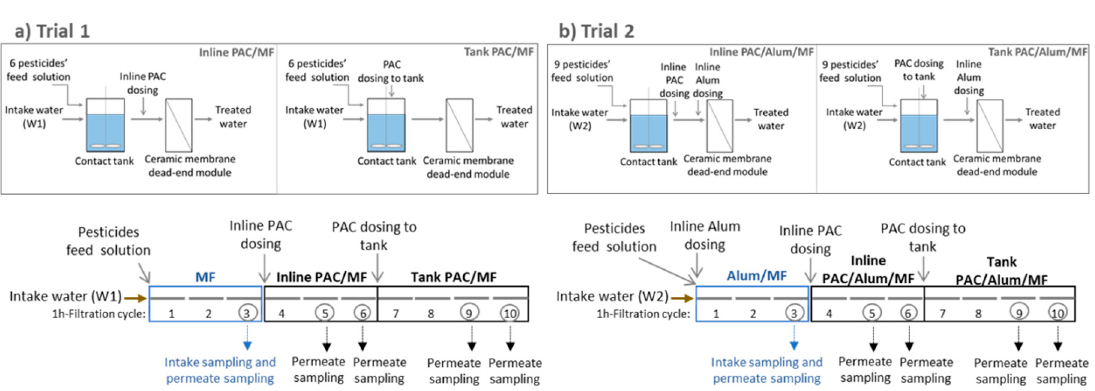
Figure 1. Scheme of PAC/(Alum)/MF process (top) and procedure followed (bottom) during trial 1 ( a ) and trial 2 ( b ) (10 × 1 h-filtration cycles, with 3 cycles without PAC, 3 cycles with inline PAC dosing and 4 cycles with PAC dosing to tank).